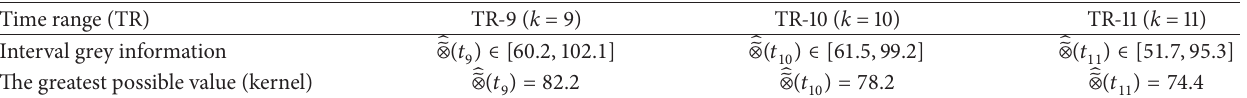
Table 5: Prediction values of concentration of DDT in atmosphere of a certain city in southern China (ng ⋅ m −3 ). Time range